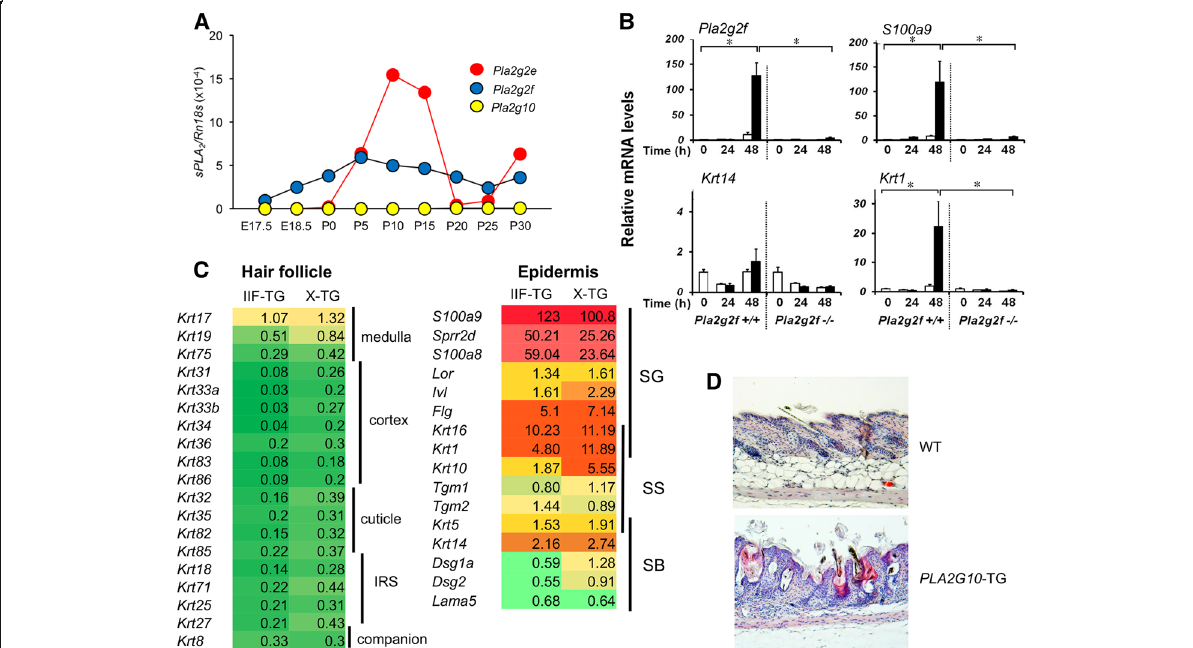
Fig. 2 Skin abnormalities in knockout and transgenic mice for various sPLA 2 s. a Developmental expression of sPLA 2 s in mouse skin as assessed by quantitative RT-PCR. Pla2g2f is expressed throughout the peri- to postnatal period, while the periodic pattern of Pla2g2e expression coincides with the hair cycle, which involves repeated cycles of growth (anagen; P0 – 15), regression (catagen; P15 – 20), rest (telogen; P20 – 25), and re-growth